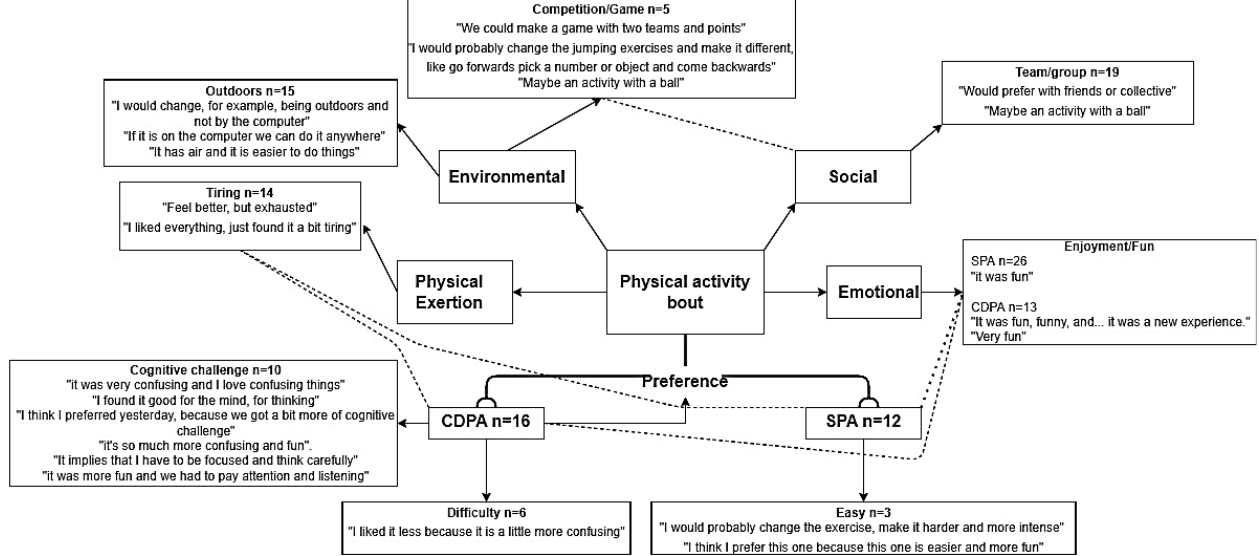
Figure 5. Diagram of children’s perceptions of the PA conditions. ------ stands for similarities.